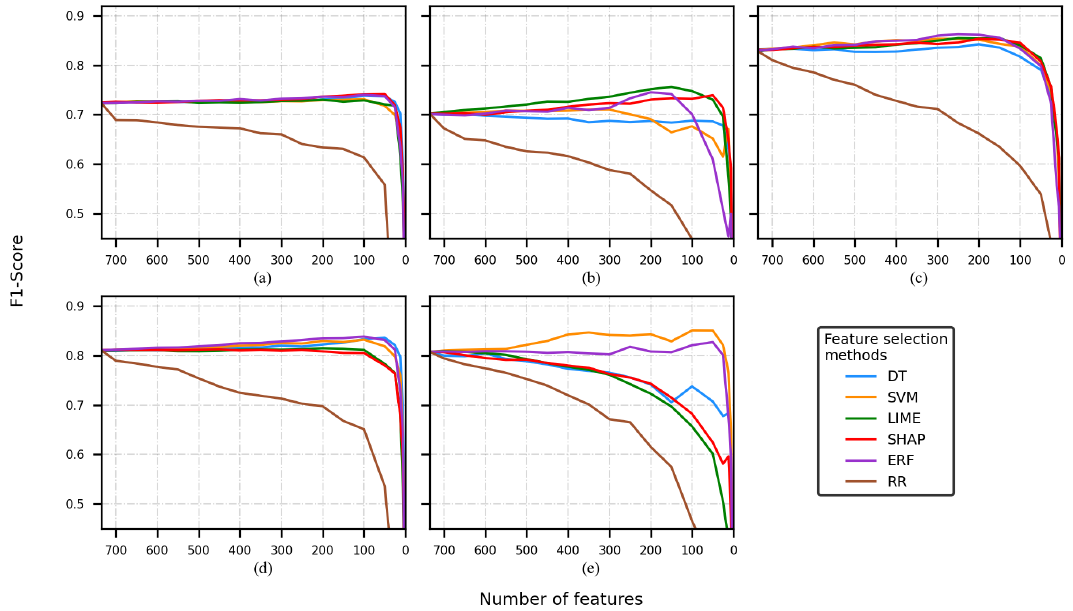
Figure 2. F1-score of the model was obtained by using a different number of features, using the CHB-MIT dataset and FS1. Classification model used: ( a ) decision tree, ( b ) support vector machine, ( c ) artificial neural network, ( d ) random forest, and ( e ) K-nearest